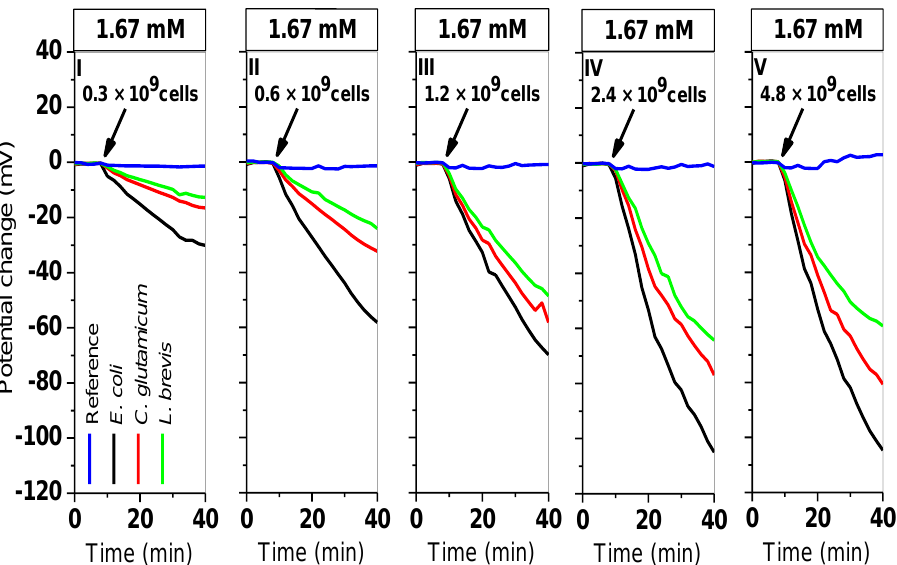
Figure 6. Four-chamber di ff erential LAPS measurement with varying cell numbers of L. brevis , C. glutamicum , and E. coli (0.3 × 10 9 , 0.6 × 10 9 , 1.2 × 10 9 , 2.4 × 10 9 , 4.8 × 10 9 cells in 200 µ L cell suspension) at a constant glucose concentration of 1.67 mM. The potential changes of five successive independent measurements (Nr. I–V) with an increasing number of cells are plotted. Blue line: reference sensor signal without cells; black ( E. coli ), red ( C. glutamicum ), and green ( L. brevis) lines are active sensor areas with cells. Four laser-diode modules (LDMs) were considered for each chamber (each curve corresponds to the calculated mean values).